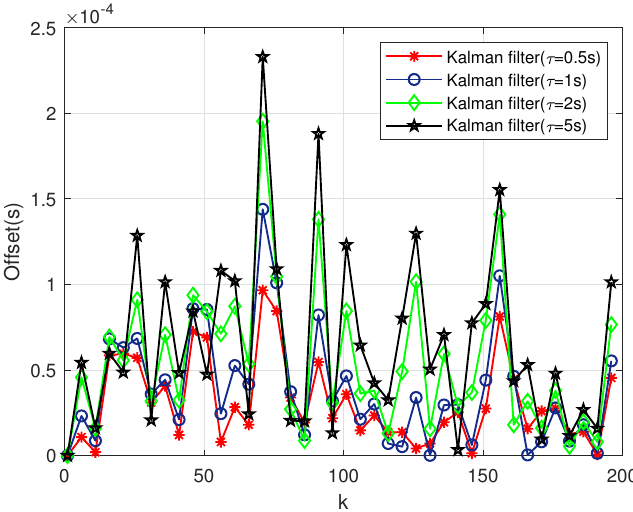
Figure 6. Clock Offset Error with Different Sampling